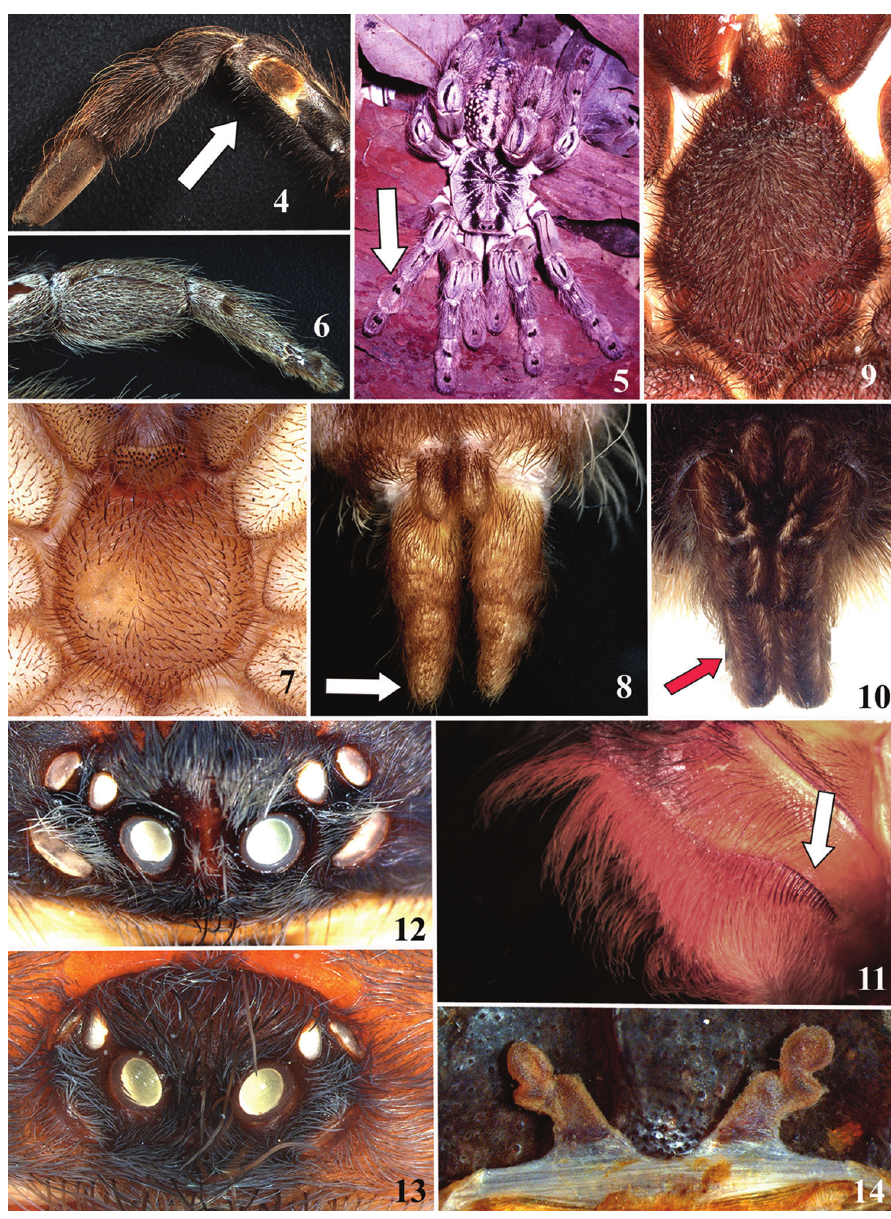
Figures 4–14. Aviculariinae characters. 4 Ephebopus murinus , palp with paddle of urticating setae type V (arrow) on prolateral side 5–6 Heteroscodra sp. 5 black marks (arrow) on dorsal tibiae, metatarsi and tarsi 6 tibia IV incrassate 7 Typhochlaena curumim , sternum as long as wide 8 Typhoclaena seladonia , posterior lateral spinnerets with domed article (arrow) 9–10 Avicularia merianae sp. n. 9 sternum longer than wide 10 posterior lateral spinnerets with digitiform distal article (arrow) 11 Psalmopoeus sp., stridulatory setae forming a lyra (arrow) on prolateral maxilla 12 Tapinauchenius sp., straight anterior row of eyes 13 Avicu- laria avicularia , anterior row of eyes strongly procurve 14 Iridopelma hirsutum ,